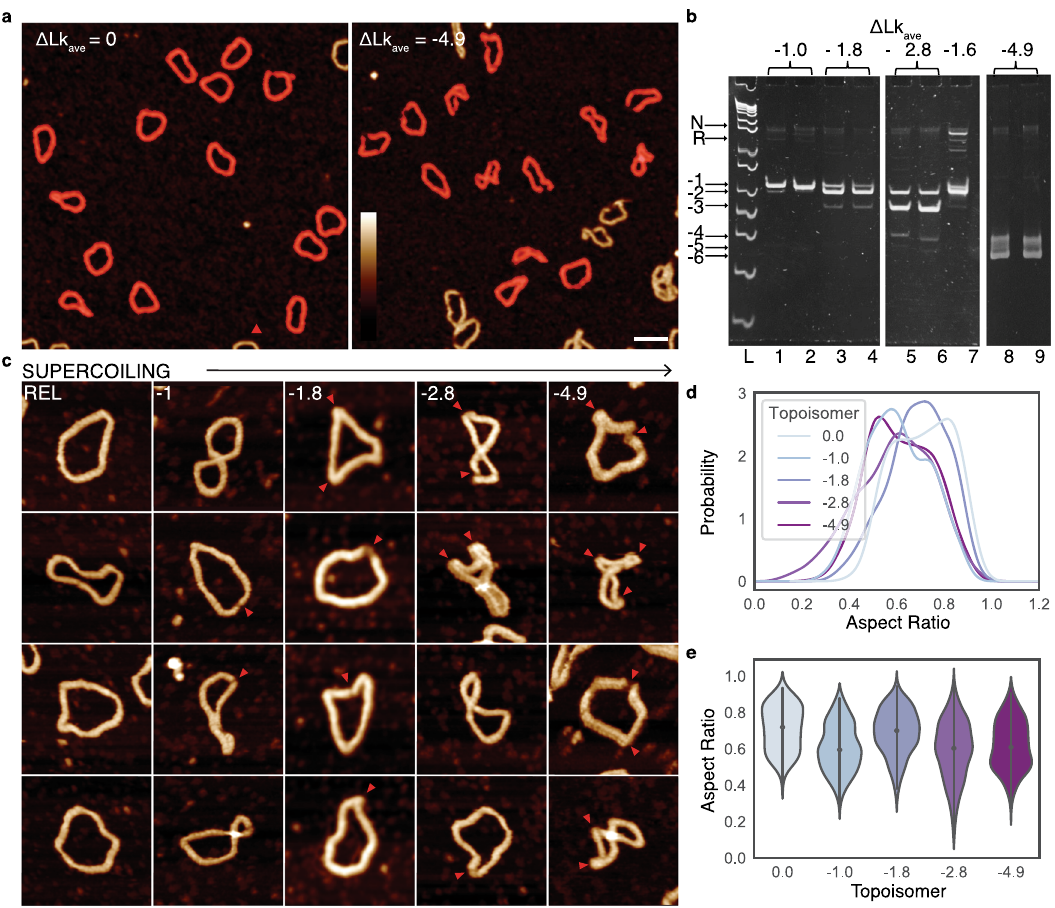
Fig. 3 Negative supercoiling induces global compaction of DNA minicircles, with a conformational change observed at physiological levels of supercoiling. a AFM images of DNA minicircle populations show increased writhe and compaction at increased negative superhelical density. Images are processed to obtain individual minicircles (red) for analysis 60 . Height scale (inset): 4 nm and scale bar: 50 nm. b Five percent TAC acrylamide gel of negatively supercoiled topoisomers of 339 bp ( Δ Lk from − 1 to − 4.9) generated by the addition of increasing amounts of ethidium bromide during the re- ligation reaction. Δ Lk = − 4.9 is taken from a separate gel image. N = nicked minicircle; R = relaxed minicircle; markers (left-hand lane) are low molecular weight DNA ladder from NEB (sizes from bottom are: 25, 50, 75, 100, 150, 200, 250, 300, 350 and 500 bp). c Representative images of 339 bp minicircles for a range of superhelical densities showing increased levels of compaction and defects (observed as regions of high bending angle, or discontinuities in DNA structure, marked by red arrowheads) for highly supercoiled minicircles. Height scale (inset, a ): 4 nm and all images are 80 nm wide. d The relationship between minicircle aspect ratio and supercoiling as a Kernel Density Estimate (KDE) plot of the probability distribution for each topoisomer ( N = 1375). e The relationship between minicircle aspect ratio and supercoiling shown as a violin plot for each minicircle